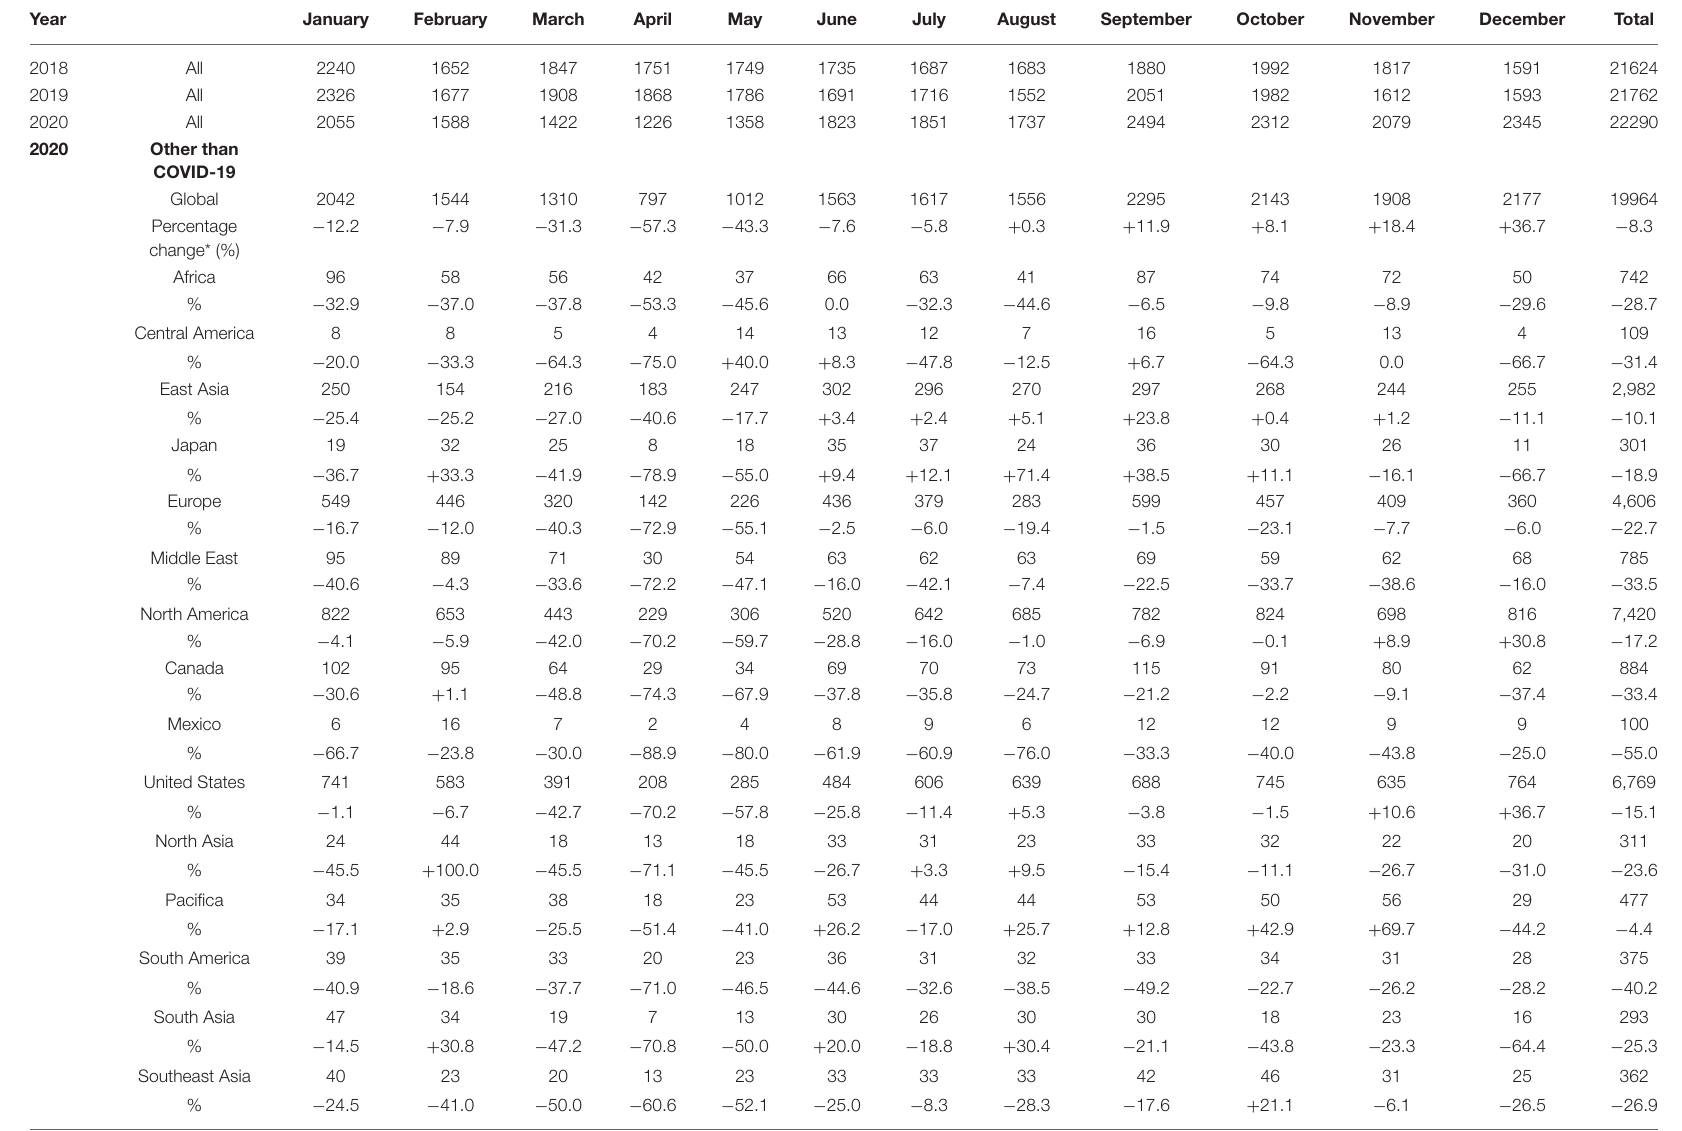
TABLE 1 | Number of newly started clinical